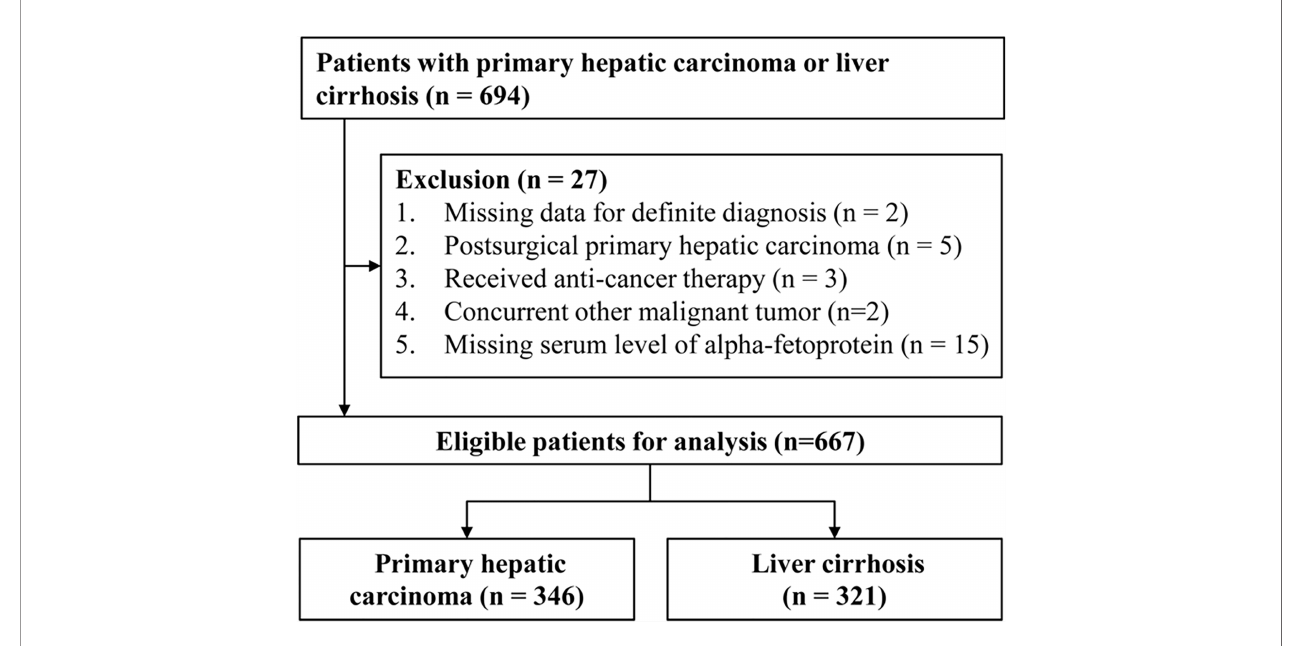
FIGURE 1 | The fl owchart of patient